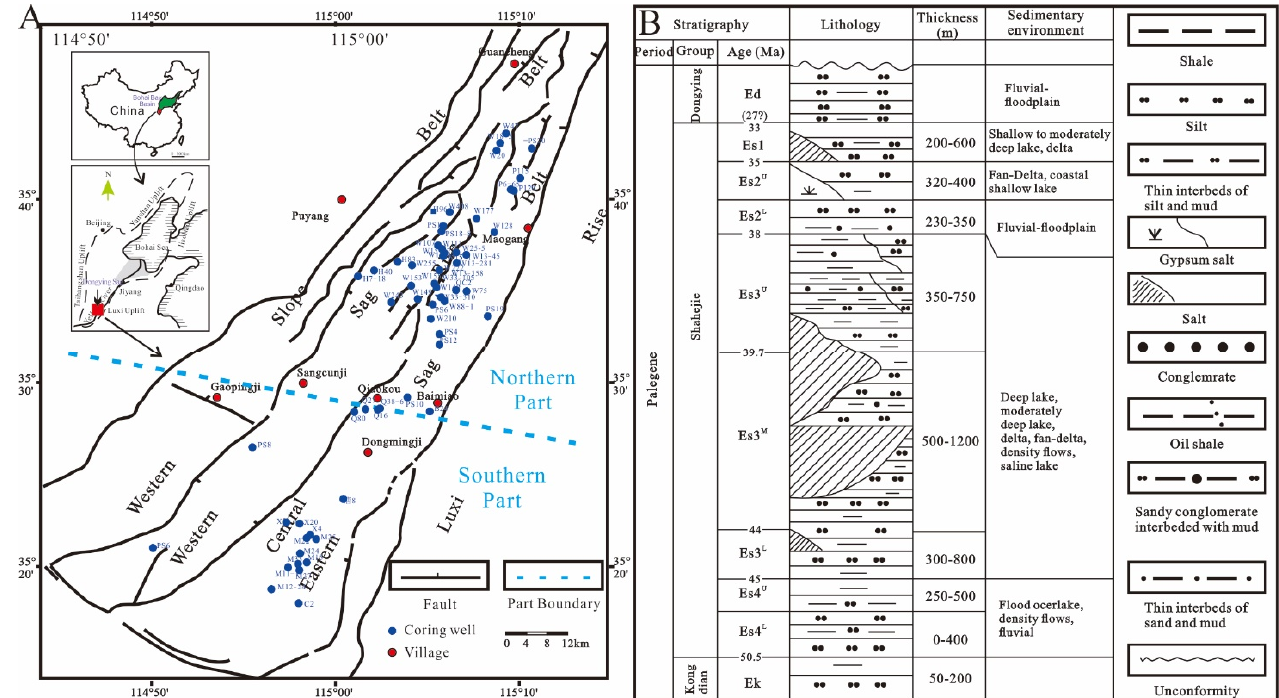
Figure 1. Geological settings of study area. ( A ) Location and structural features of Dongpu Sag; ( B ) geology synthesis columnar section of study formation.